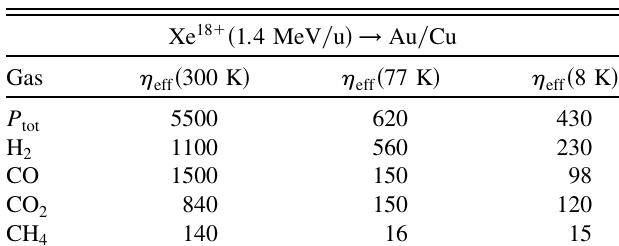
continuously bombarded under (cid:2) ¼ 0 (cid:2) with 1 : 4 MeV = u Xe 18 þ